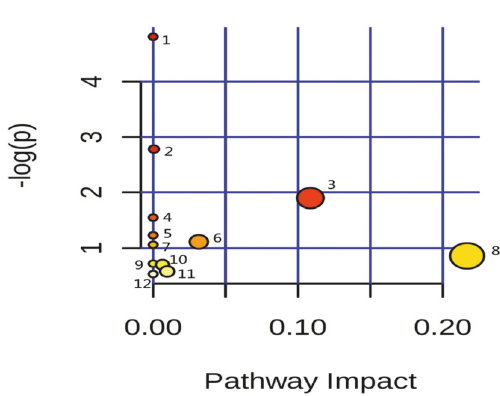
Figure 4: Differential metabolite related pathway. Note that num- bers 1-12 represent different metabolic pathways, the name of metabolic pathways, and distribution parameters as shown in Table 10.